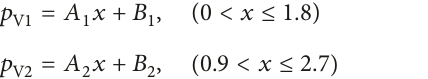
(3b), and the vertical pressure coefficient on slab from h= 1m to h= 7m can be gained. The results are shown in Table 4.